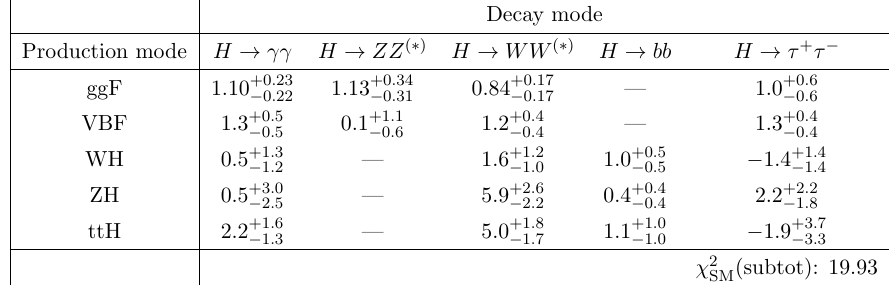
Table 1 . (Tevatron: 1.96 TeV) The signal strengths data from Tevatron (10.0 fb (cid:0) 1 at 1.96 TeV).